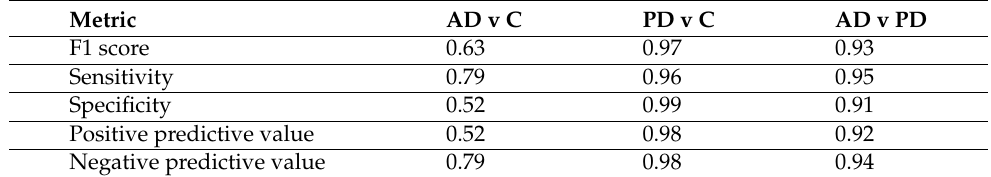
Figure A5. Precision–Recall Curves for binomial elastic net regressions classifying ( a ) controls against subjects with AD; ( b ) controls against subjects with PD; and ( c ) subjects with AD against subjects with PD, using the same predictions as Figure 2. Each line represent models formed using one of the five missing data imputed datasets. The average Area Under the Curve (AUC) is displayed in the bottom right. Table A1. A display of various cutoff-dependent metrics, using the same leave one out predictions displayed in Figures 2 and A5. In each case, the cutoff is chosen to maximize F1